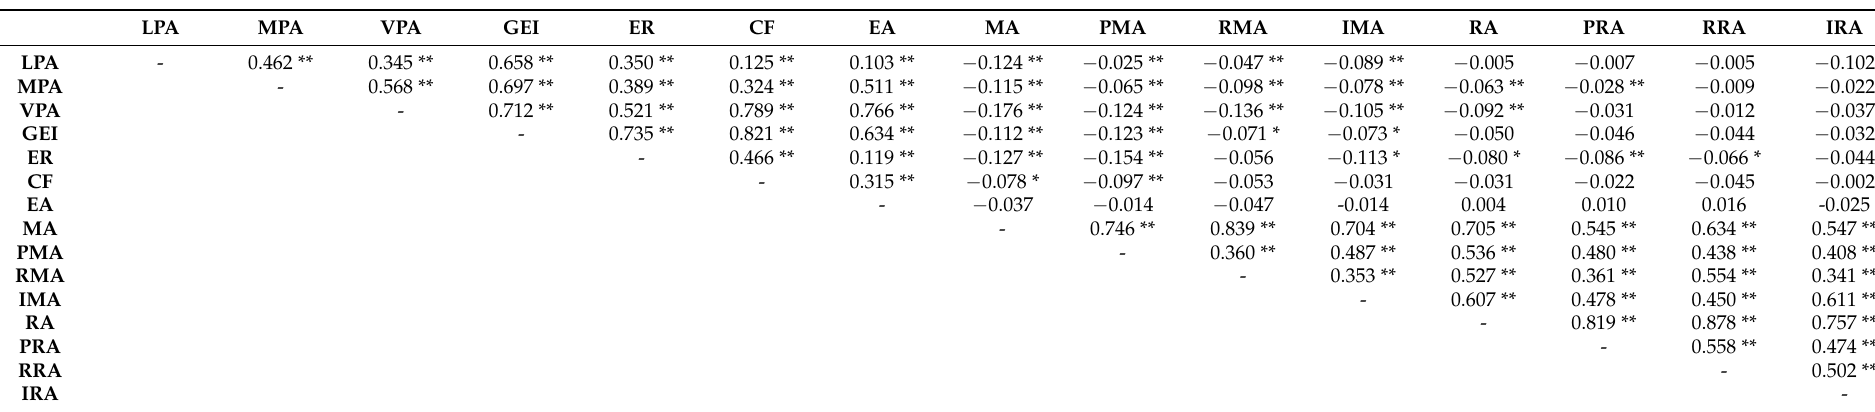
Table 3. Bivariate correlations between PA, EI, and aggressive behaviours for